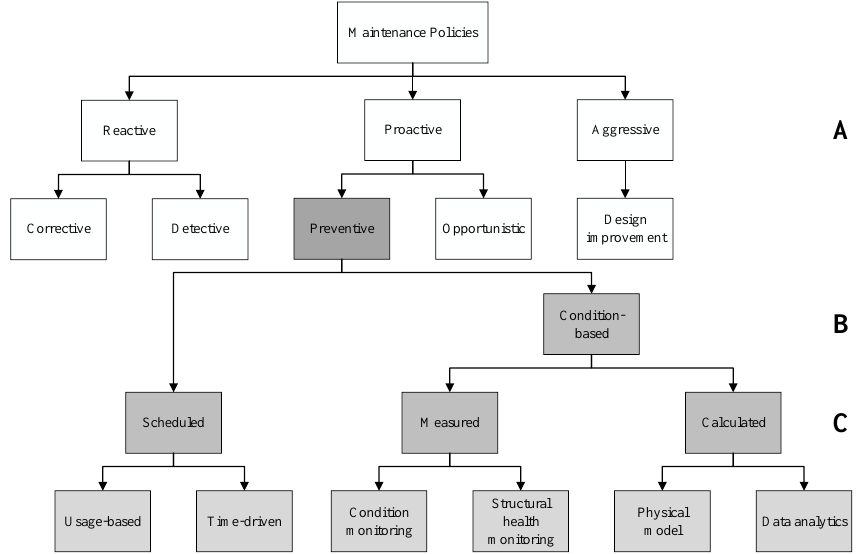
Figure 1. Overview of maintenance policies. At level A the main policy category is selected, level B (scheduled or dynamic) and level C (measured or calculated) distinguish the various preventive policies.